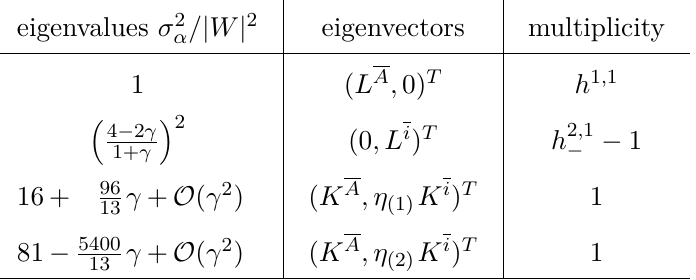
and η take the form η = 1 + 25 γ + O ( γ 2 ) (1) (2) (1) 3 39